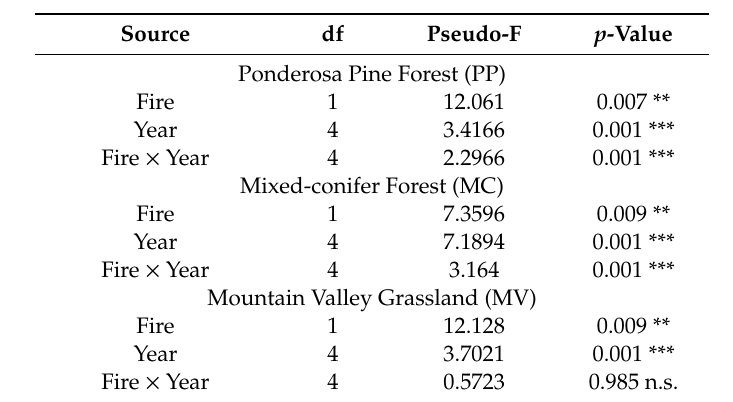
Table 1. PERMANOVA results for arachnid genera (and some higher taxa) for e ff ects of fire, year, and their interaction for ponderosa pine forest, mixed-conifer forest, and mountain valley grassland at the Valles Caldera. ** 0.01 > p > 0.001, *** p = 0.001, n.s. = not significant.